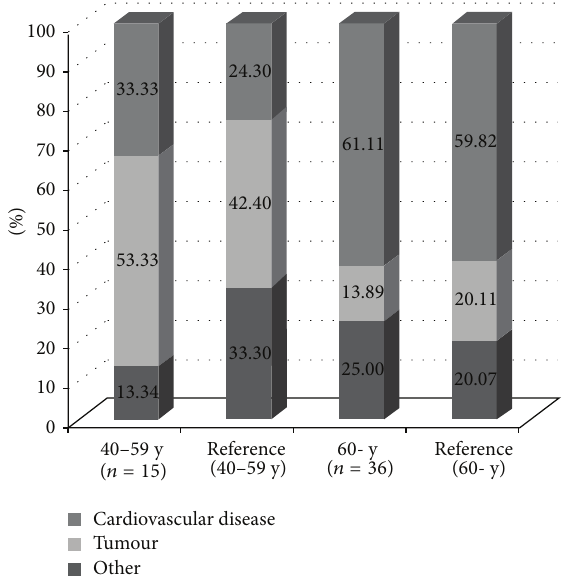
Figure 2: Comparison of the causes of death between our patients’ data and the sex- and age-adjusted data on general Hungarian population. Table 4: Standardized mortality ratios (SMRs) of pSS subgroups. Standardized mortality ratios (SMRs) Whole pSS population ( 𝑛 = 547 ) 1.32 Female patients ( 𝑛 = 487 ) 1.49 0.65 Patients without EGMs ( 𝑛 = 117 ) 0.51